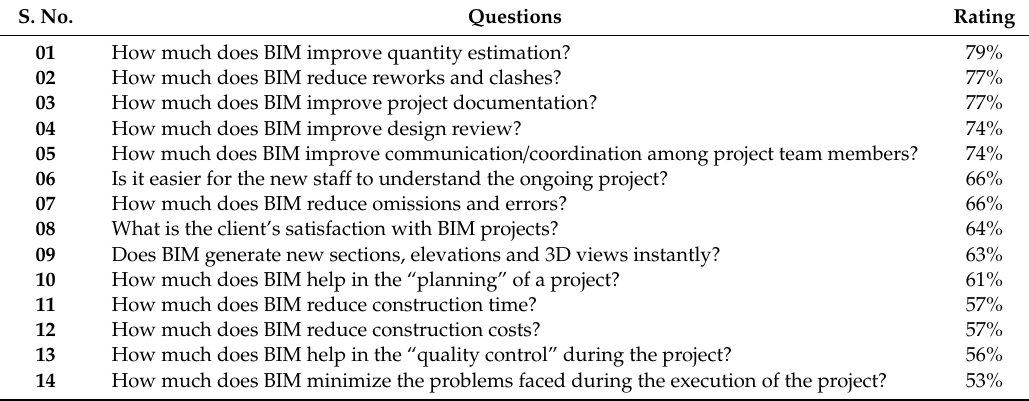
Table 3. Questions about implementation of BIM in Table 3 . Questions about implementation of BIM in projects . Table 3 . Questions about implementation of BIM in projects .